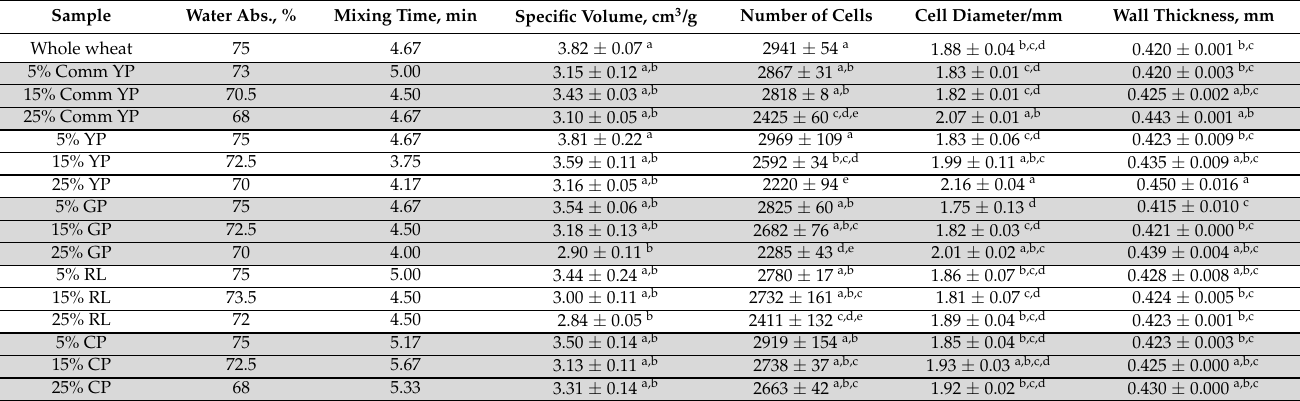
Table 4. Baking parameters, specific volume, and C-cell properties of whole wheat/pulse bread. Sample Water Abs.,